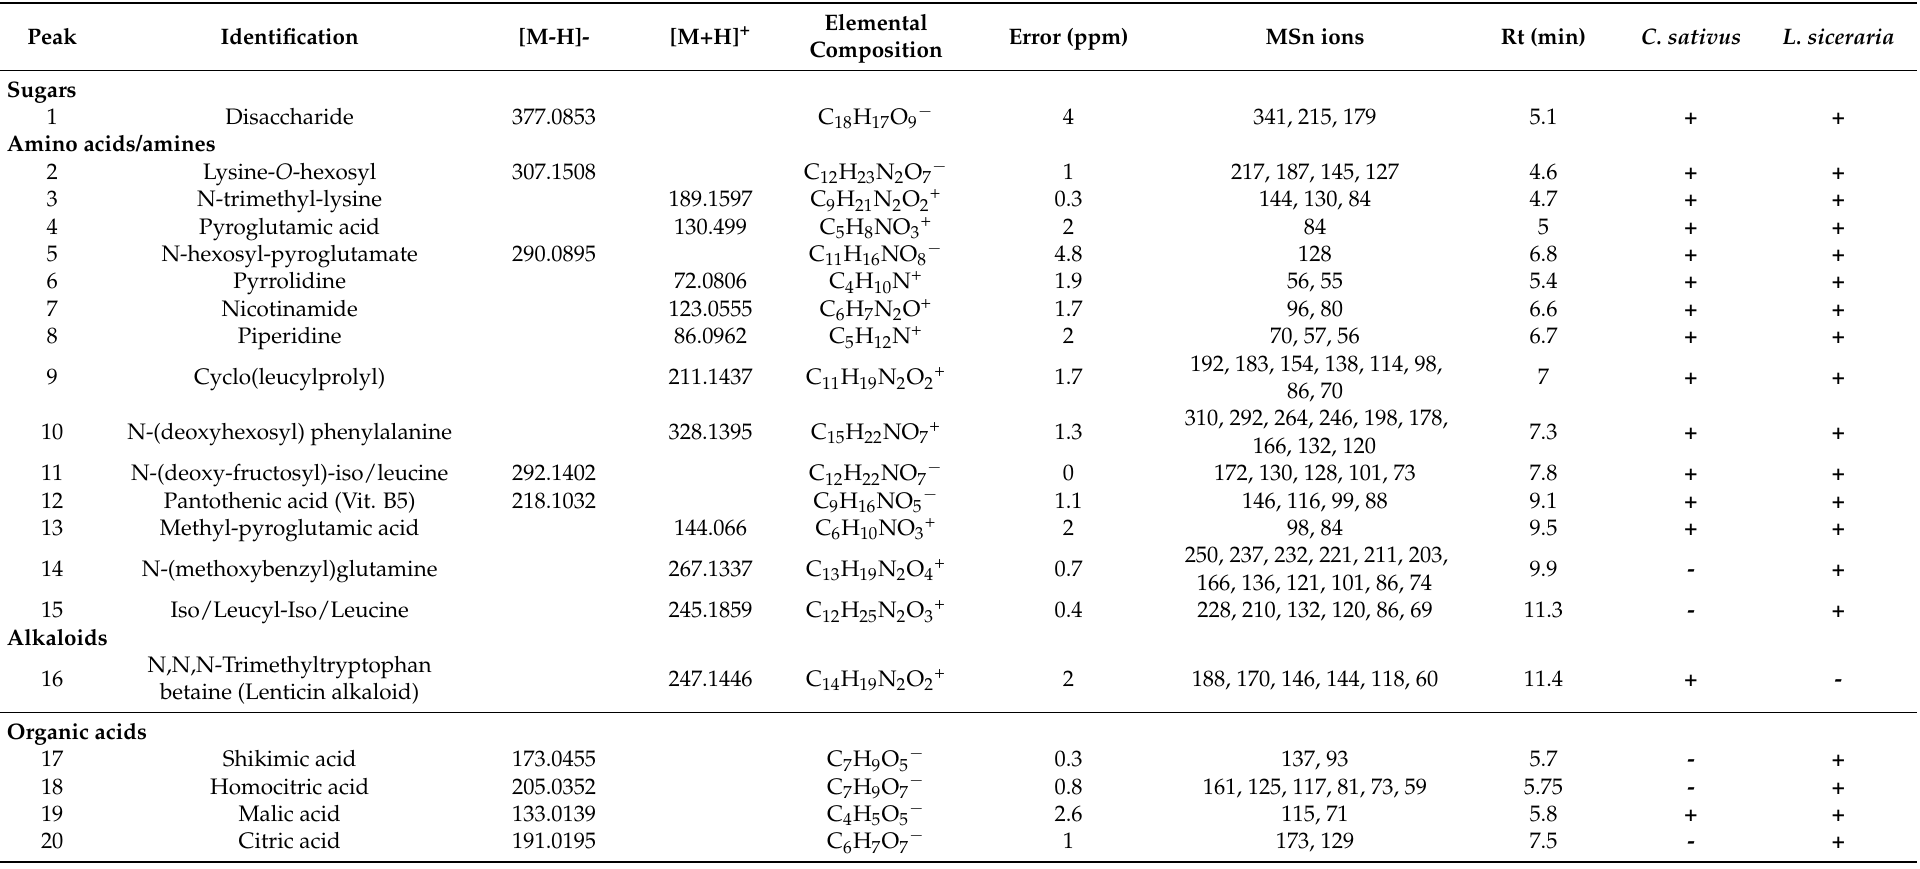
Table 1. Metabolome profiling of Cucumis sativus and Lagenaria siceraria crude fruit extracts via HR-UPLC/MS/MS in both negative and positive modes of